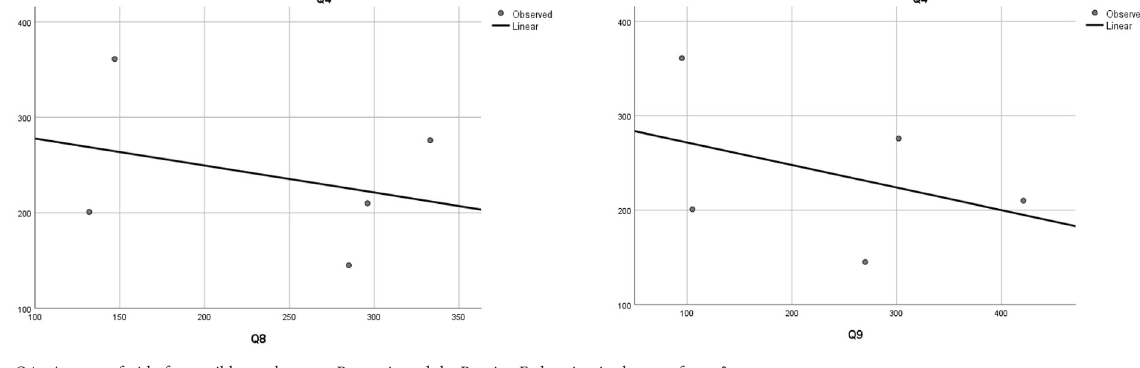
Q4 - Are you afraid of a possible war between Romania and the Russian Federation in the near future? Q8 - To what extent do you feel protected by the fact that Romania is a NATO member state? Q9 - To what extent do you consider the presence of NATO military capabilities on the territory of our country to be beneficial for Romania’s